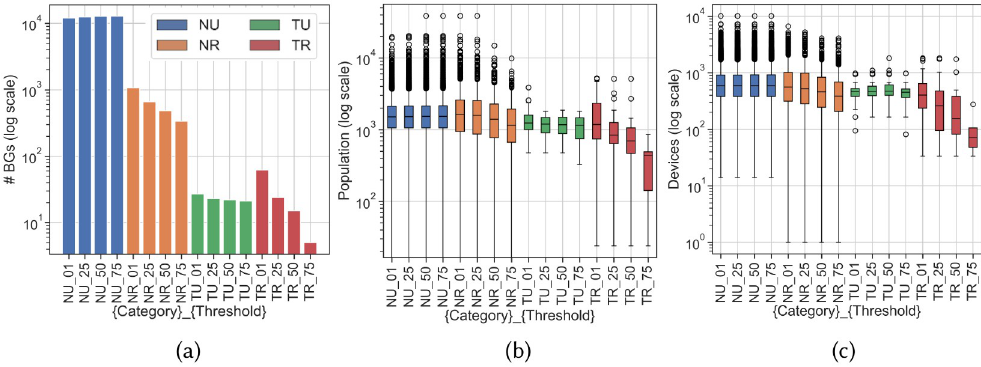
Fig 6. Variation in sparsity factors from labeling scheme thresholds in T/N and U/R category clusters. (a) Block groups appearing in each cluster by different labeling thresholds. The number of BGs labeled rural (R) varies logarithmically depending on threshold cutoffs, while urban (U) BG counts are more linear across thresholds. Tribal BGs show the expected order of magnitude difference from non-tribal, but do not show visible trends at this scale. (b) Populations of clustered BGs vary more widely in rural BGs across clusters than in urban, with non-tribal BGs showing higher outliers. Tribal clusters show greater logarithmic variation than non-tribal. (c) Device counts show similar trends as population, with more linear variation over thresholds for the TU